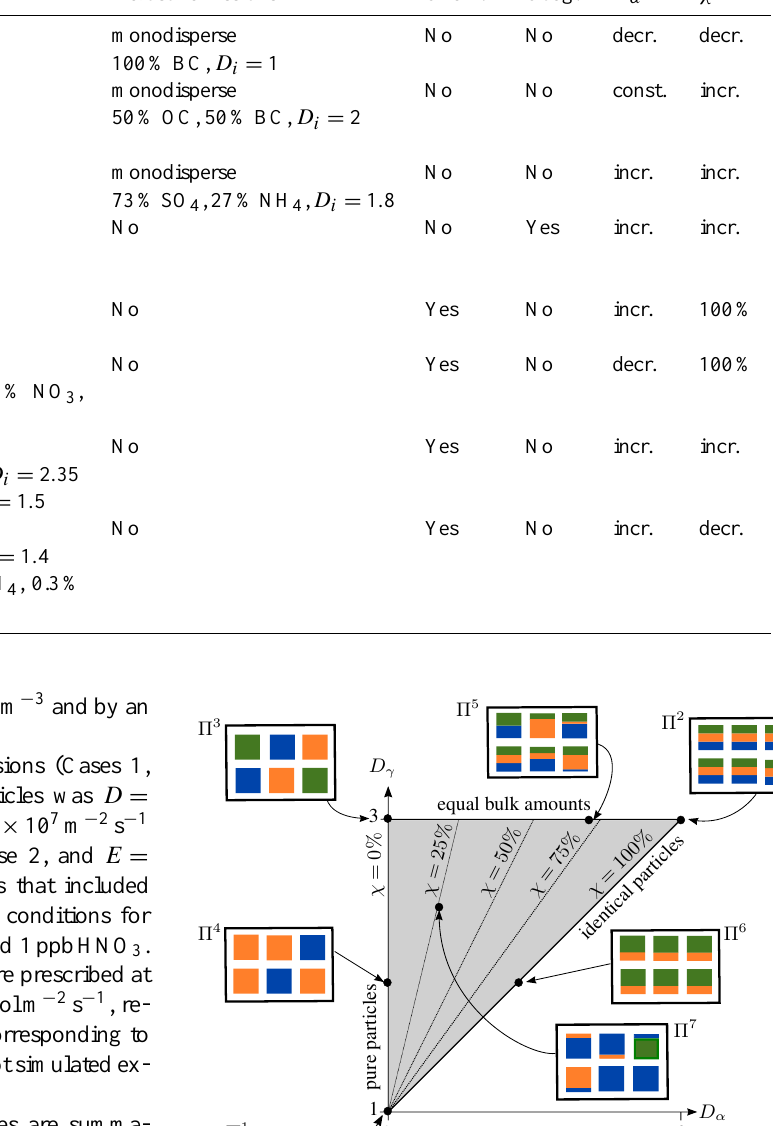
Fig. 2. Mixing state diagram to illustrate the relationship between per-particle diversity D α , bulk diversity D γ , and mixing state index Fig. 26: Mixing state diagram to illustrate the relationship be- χ for representative aerosol populations, as listed in Table 4. See tween per-particle diversity D ↵ , bulk diversity D  , and mix- Section 2 and Table 3 for more details. ing state index  for representative aerosol populations, as listed in Table ?? . See Section 2 and Table ?? for more de- tails. and condensation were not simulated. Depending on the rel- ative magnitudes of the per-particle diversities of the emitted versus the pre-exisiting particles, emissions can have differ- ent impacts on the aerosol mixing